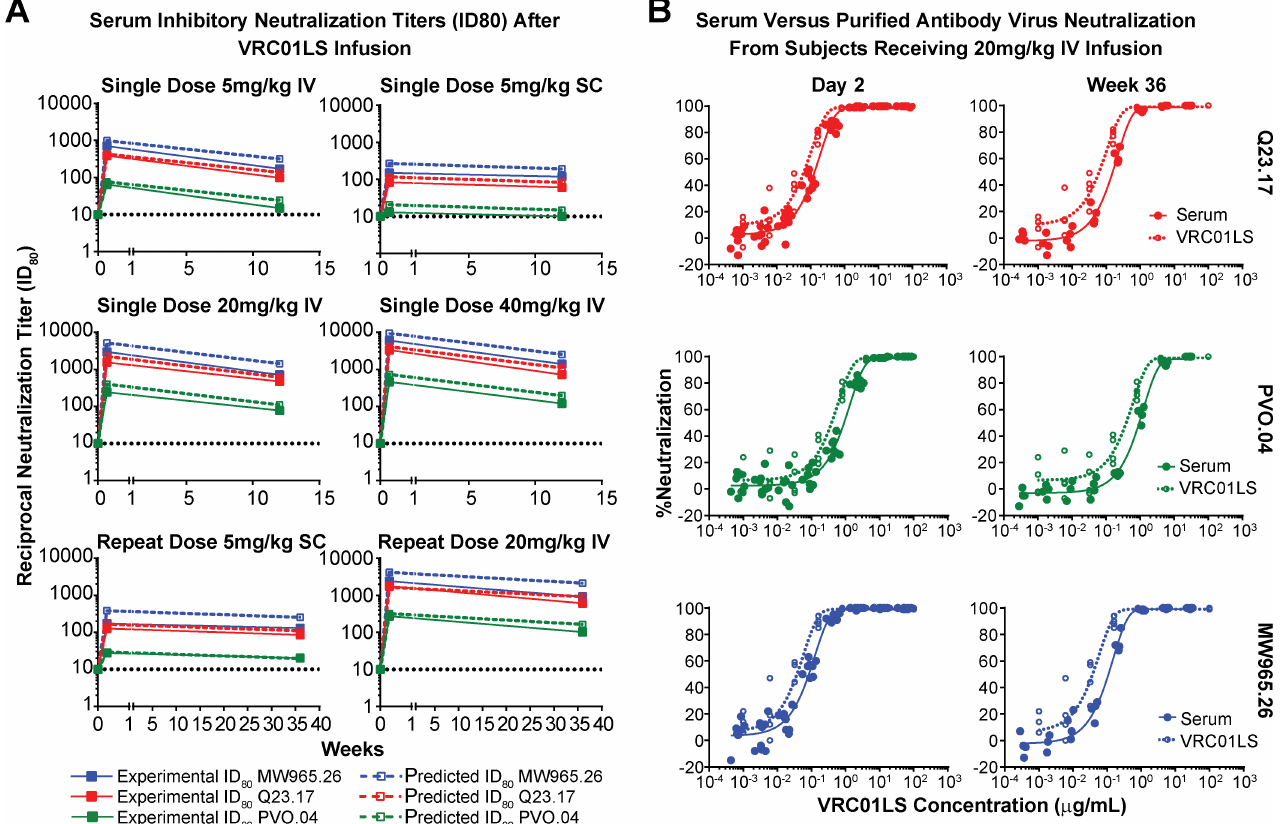
Fig 4. Neutralizing ability of VRC01LS is maintained in serum after infusion. (A) Serum inhibitoryneutralization titers (ID 80 ) after VRC01LS infusion.Solid lines and closed squares indicatethe reciprocalserum dilutionthat produces 80% virus neutralization for three viral strains. Dashed lines and open squaresindicatepredictedID 80 basedon the measuredamount of VRC01LSin the serum and the known inhibitoryconcentration (IC 80 ) of VRC01LSfor the viruses tested: MW965.26,0.128 μ g/mL; Q23.17, 0.298 μ g/mL; and PVO.04, 1.66 μ g/mL. All final time points were assessed12 weeks after the final dose was administered. Values are the mean of duplicatewells run in the same plate. (B) Examples of serum and VRC01LSneutralization curves. Serum from day 2 and week 36 samples (closedcircles) were used to generateneutralizationcurves (solid lines) that are comparedto neutralization curves generatedwith uninfusedVRC01LS IgG antibody (open circles and dashed lines)at different dilutions. The x-axis displaysboth the VRC01LSconcentration acquiredfrom serum and in vitro dilutionsof uninfusedantibody.IC 80 , 80% inhibitory concentration; ID 80 , dilutionthat produced80% neutralization; IgG, immunoglobulinG; IV, intravenous; SC, subcutaneous.